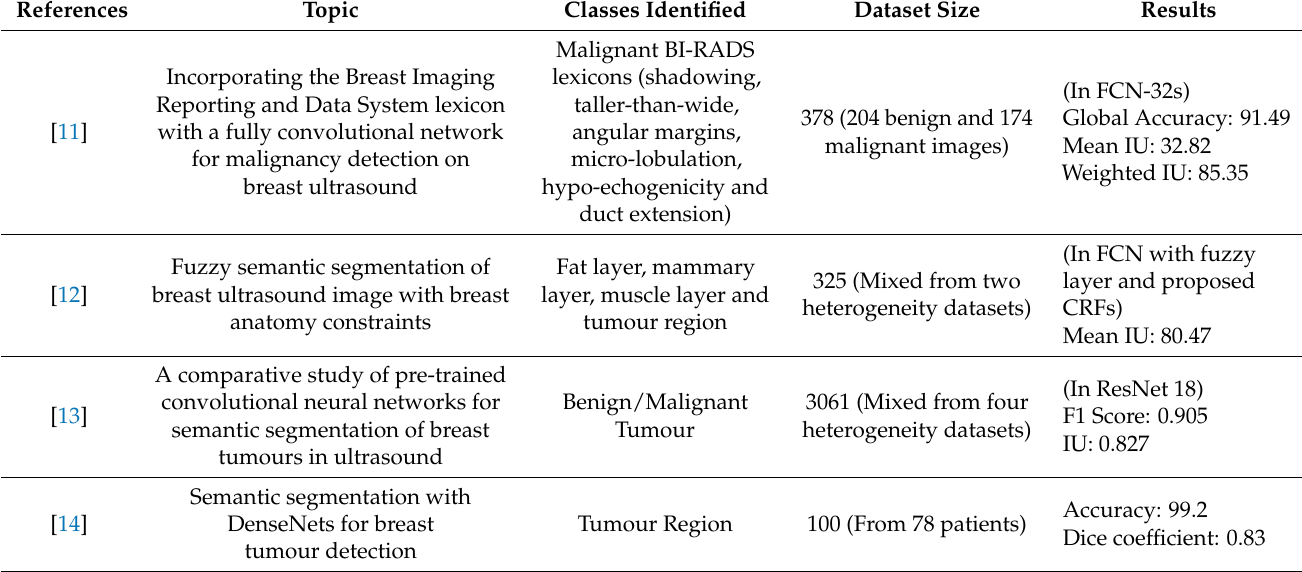
Table 1. Summary of related semantic segmentation studies with their modalities and